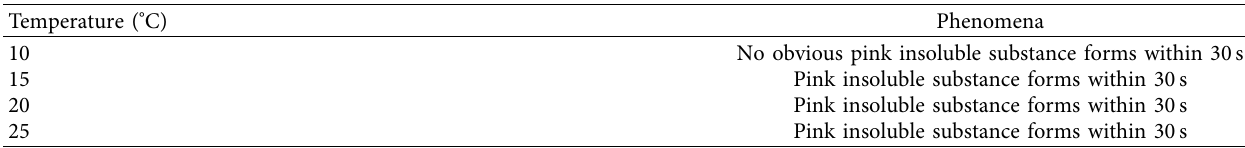
Table 3: Effect of temperature on colorimetric